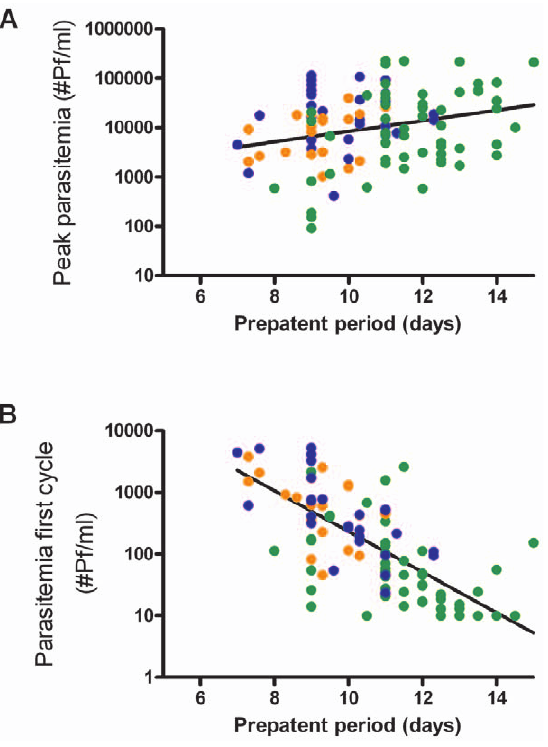
Figure 4. Correlation of Q-PCR parasitemia with prepatent period. Correlation between peak parasitemia (A) or geometric mean parasitemia during the first multiplication cycle from day 6.5 to day 8.5 (B) with prepatent period (R 2 = 0.27 and 2 0.73, p =0.006 and p= , 0.001, respectively). Prepatent period was defined as the time between exposure to infectious mosquito bites until detection of blood stage parasites by microscopy.